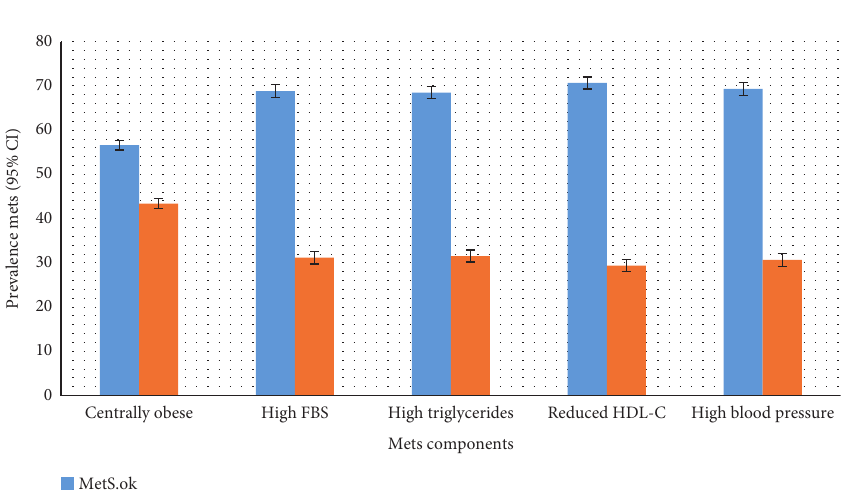
Figure 2: The prevalence of each components of metabolic syndrome in our study.